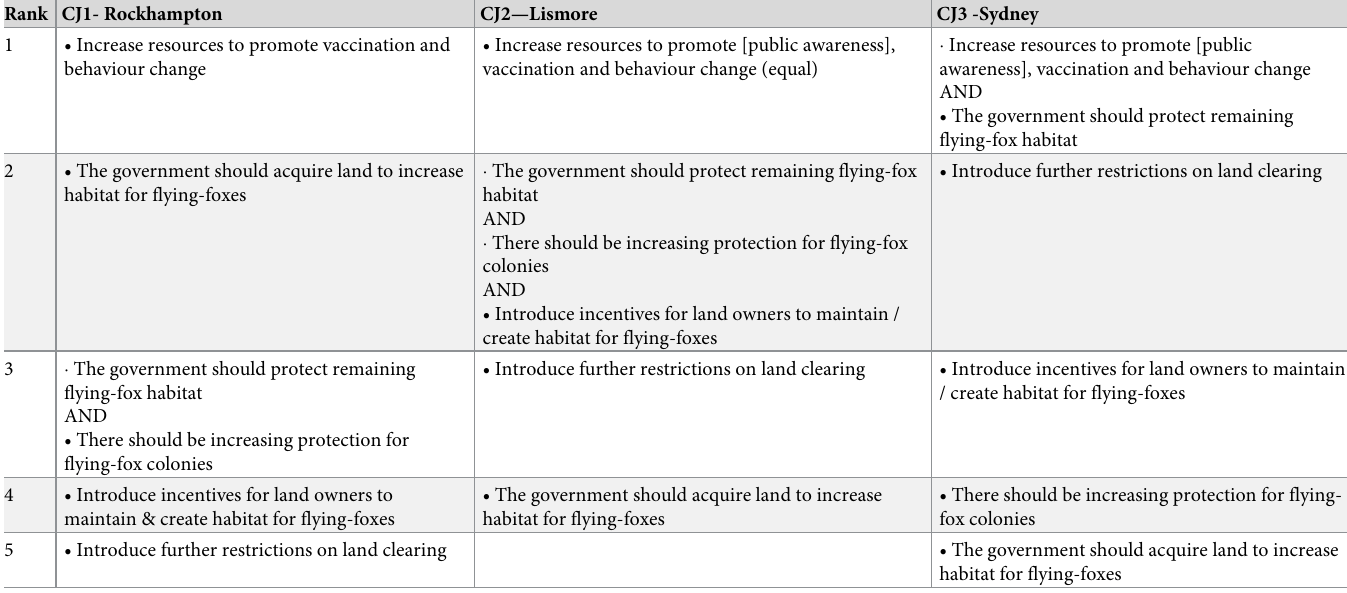
Table 2. The final rankings of each jury for different